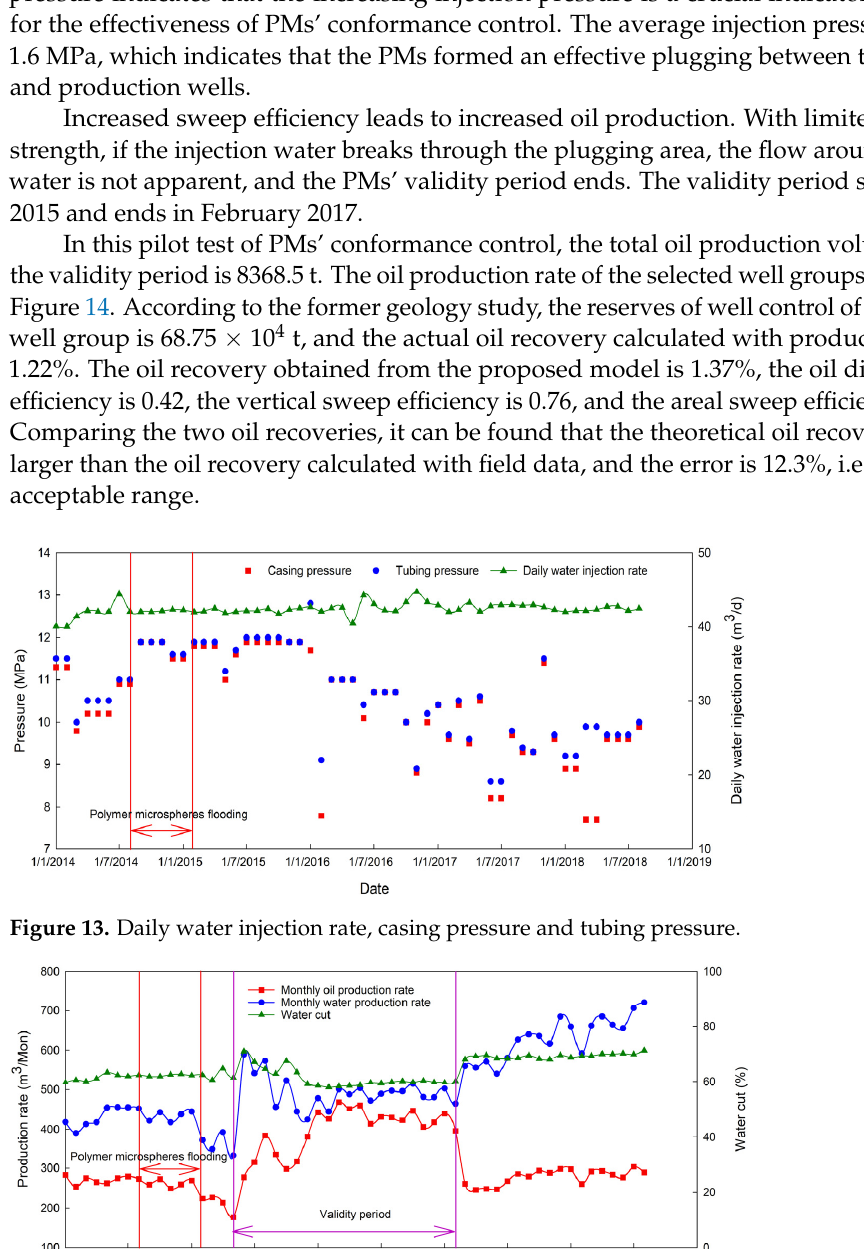
Table 4. PMs injection scheme of PM800.